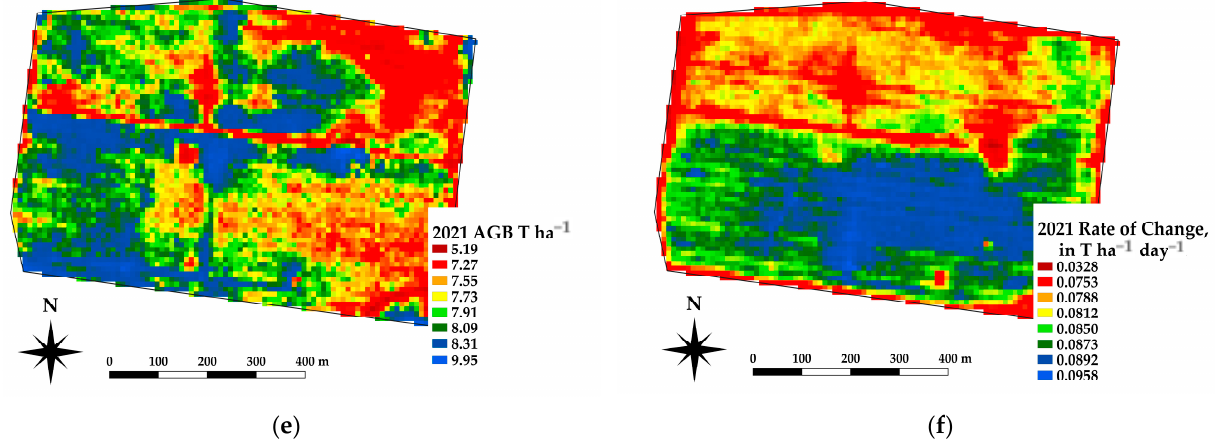
Figure 11. Example estimates of AGB and Rate of Change for the same paddock sown to different crops. ( a , b ) AGB and ROC for canola at DOY 300, 2019. ( c , d ) AGB and ROC for wheat at DOY 300, 2020. ( e , f ) AGB and ROC for faba beans at DOY 300, 2021.